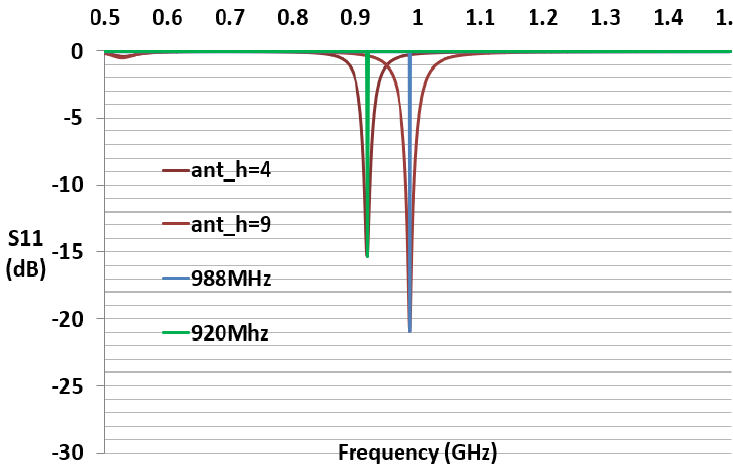
Figure 8. Simulated S11 with parameter ant_h = 4 and 9 mm.